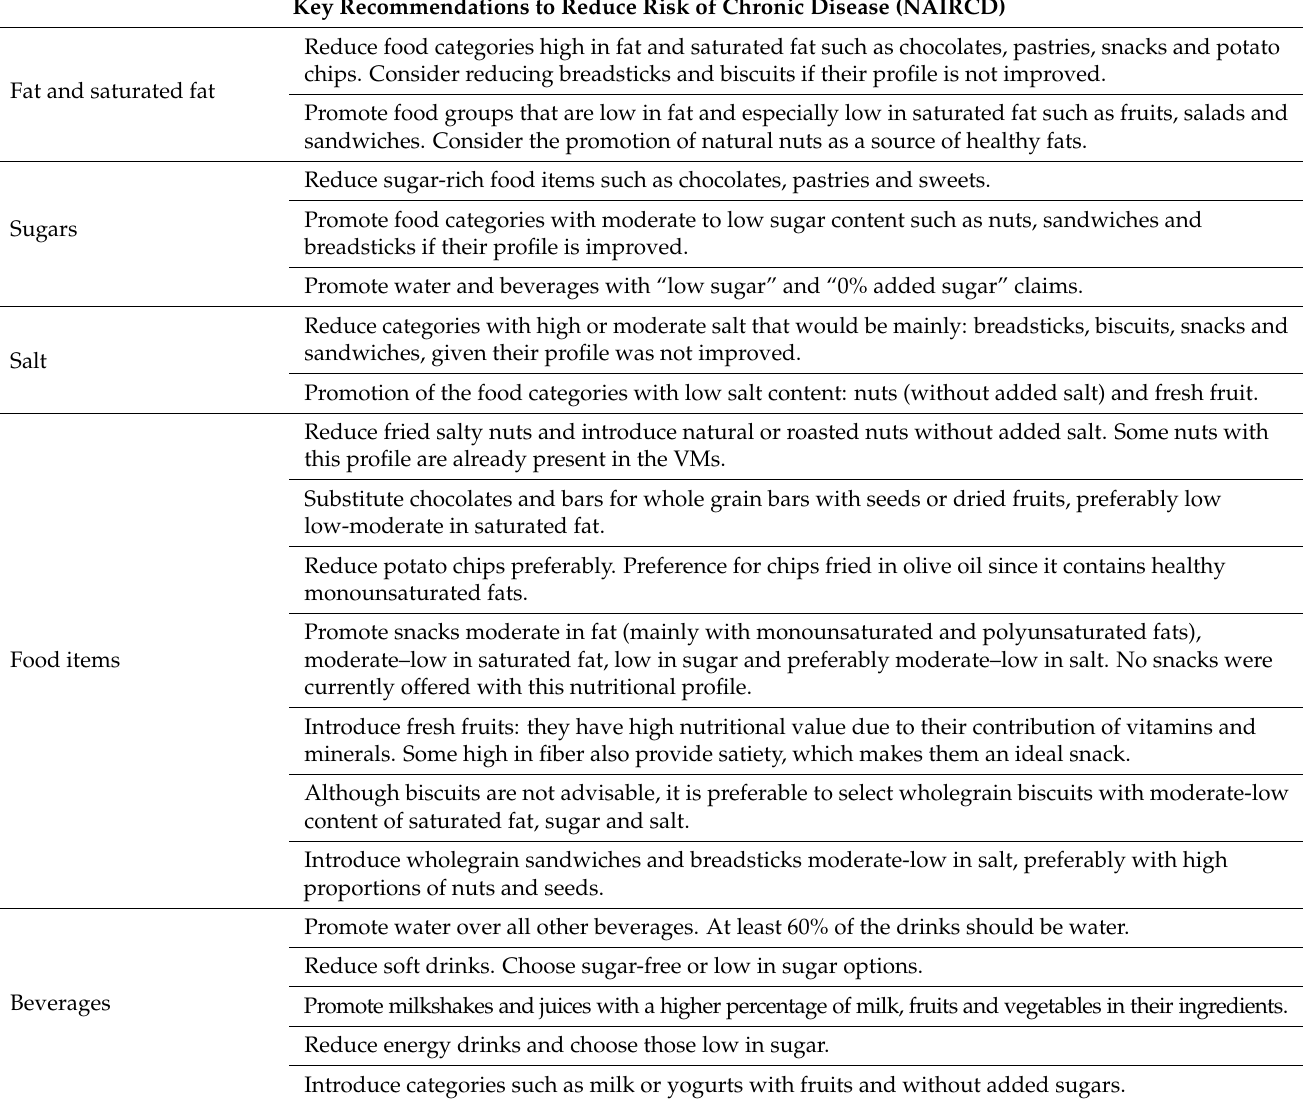
Table 4. Recommendations for the improvement of the nutritional quality of vending